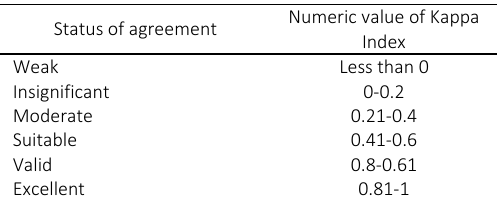
Table 3: Status of the Kappa Index